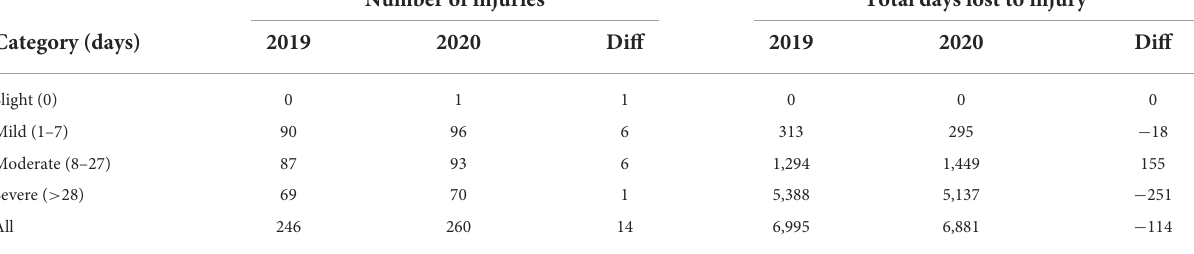
TABLE 4 Number of injuries and total days lost due to injury categorized by their